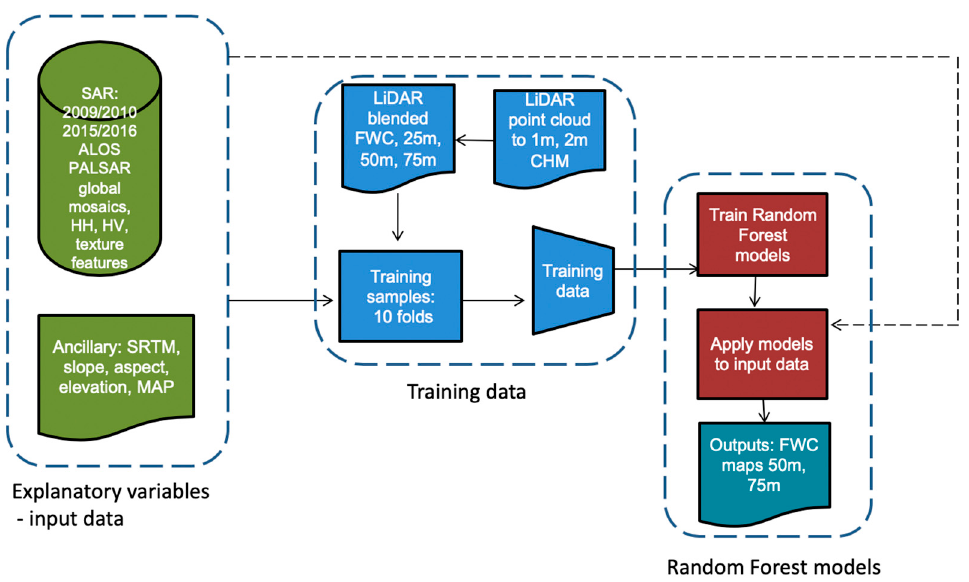
Figure 5. Diagram of operational processing system with components including explanatory input variables, training data generation from LiDAR data, random forest models, and outputs in the form of annual fractional woody cover maps.